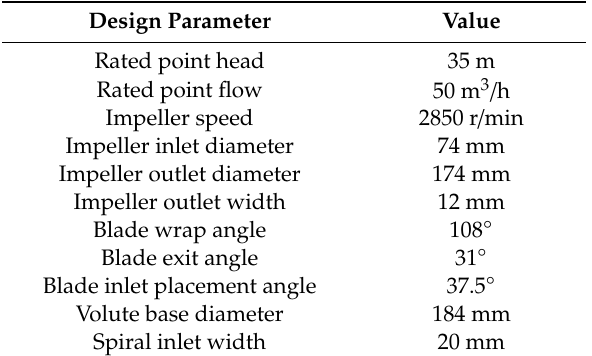
Table 1. Main design parameters of centrifugal